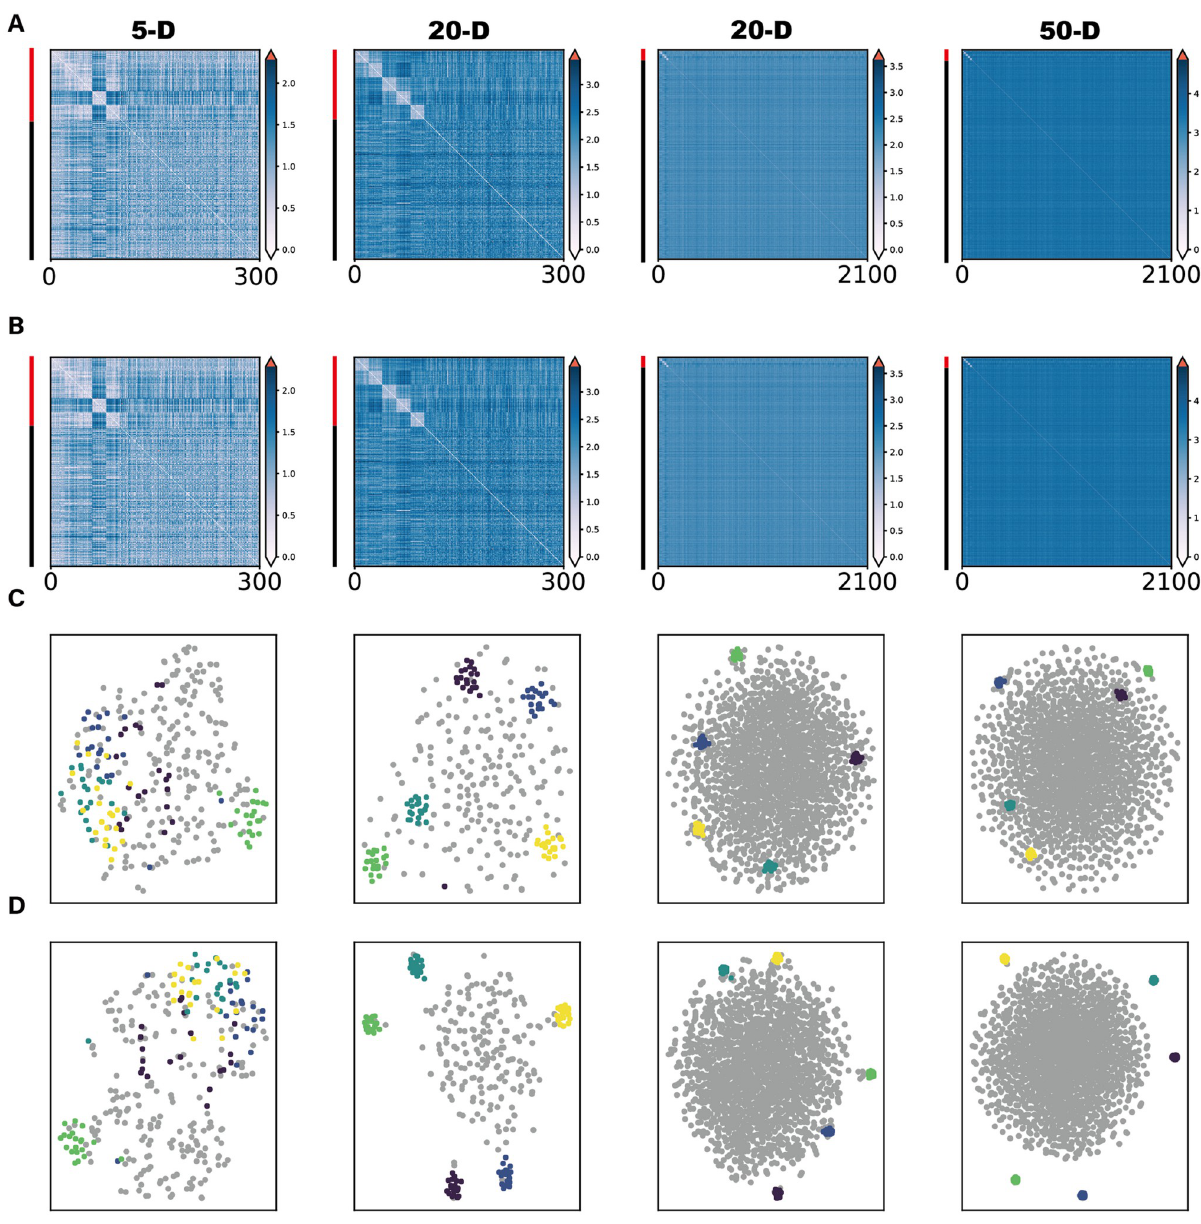
Fig 2. Influence of dimensionality and number of noise points on the performance of the DoD transformation. In these simulations, 20 cluster points were sampled from five different multivariate Gaussian distributions. The dimensionality was, from left to right, 5, 20, 20, and 50. The number of noise points was, from left to right, 200, 200, 2000 and 2000. distance-of-distances were computed w.r.t. 5 neighbor points. A : The original dissimilarity matrix. B : The dissimilarity matrix after the DoD transformation. Red bar on the left indicates cluster points and black bar indicates scattering noise points. C : t-SNE visualization based on original dissimilarity matrix. D : t-SNE visualization based on the dissimilarity matrix after the DoD transformation. Points from different clusters are labelled in different colors and noise points are labelled in